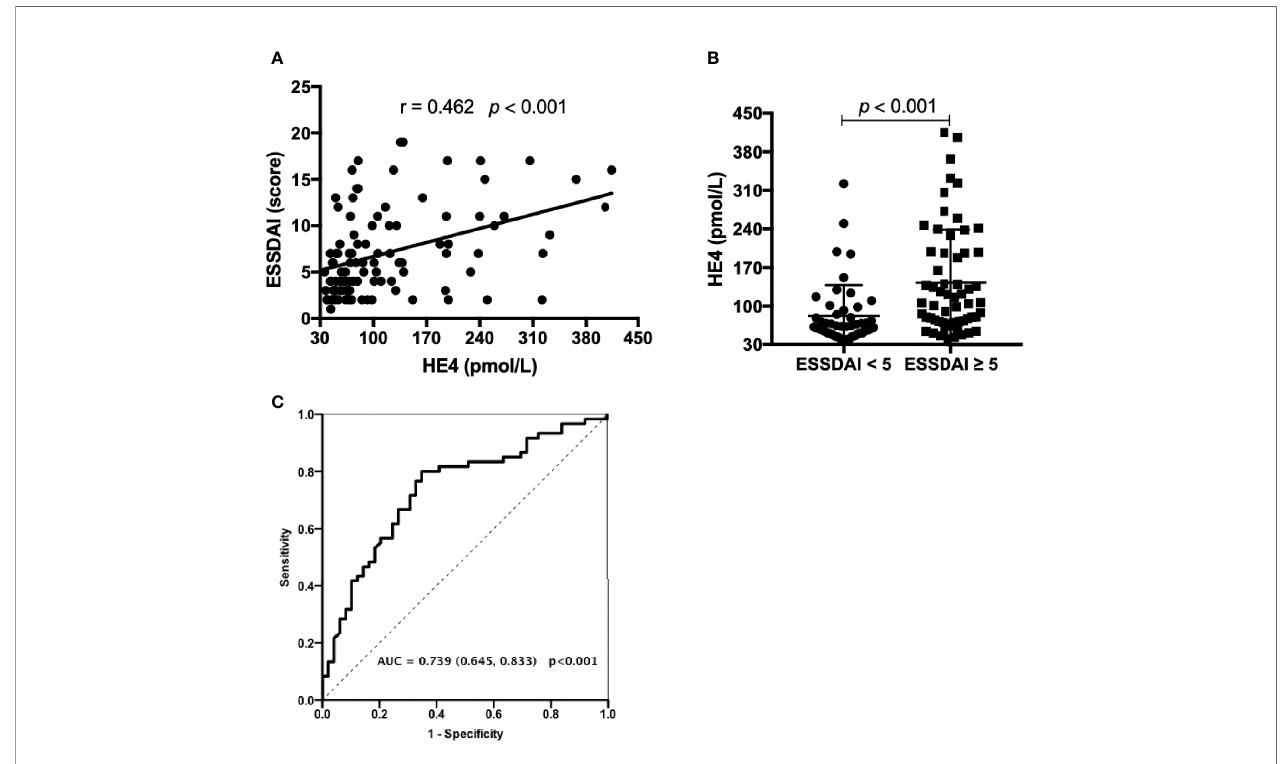
FIGURE 1 | Associations between the levels of HE4 and ESSDAI. (A) Associations between the levels of HE4 and ESSDAI. (B) Levels of HE4 were signi fi cantly higher in patients with active disease (ESSDAI ≥ 5, n = 60) than inactive disease (ESSDAI<5, n = 49). (C) Receiver operating curve analysis (ROC) on the clinical performance of HE4 in identifying patients with active disease. Statistical signi fi cance was determined by Mann-Whitney U test, Spearman ’ s correlation test and ROC analysis. ESSDAI, European league against rheumatism Sjögren ’ s syndrome disease activity